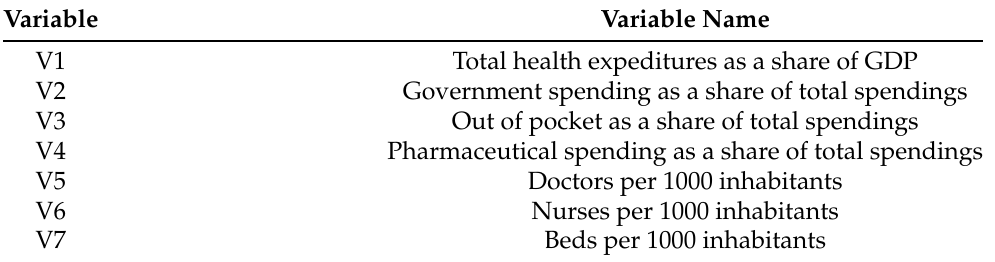
Table 1. Variables used in the survey.